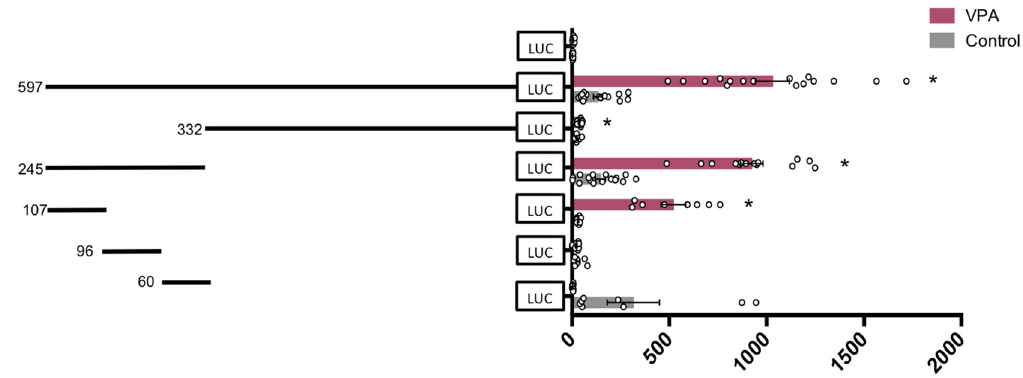
Figure 7. Response of six hVDR (human Vitamin D Receptor) gene promoter regions of 597 bp, 332 bp, 245 bp, 107 bp, 96 bp, and 60 bp to VPA (valproic acid). HepG2 cells were transfected with the pGL4-VDR-597 ( − 98 to +499), 332 (+167 to +499), 245 ( − 97 to +148), 107 ( − 107 to − 1), 96 ( − 7 to +89), and 60 (+89 to +148) constructs or pGL4 empty vector and treated with 5 mM valproate, or vehicle as control. Firefly luciferase activity was normalized with Renilla luciferase activity (relative light units, RLUs). Results are expressed as mean ± SEM from n ≥ 8 independent experiments. * p -value < 0.05, t -test.